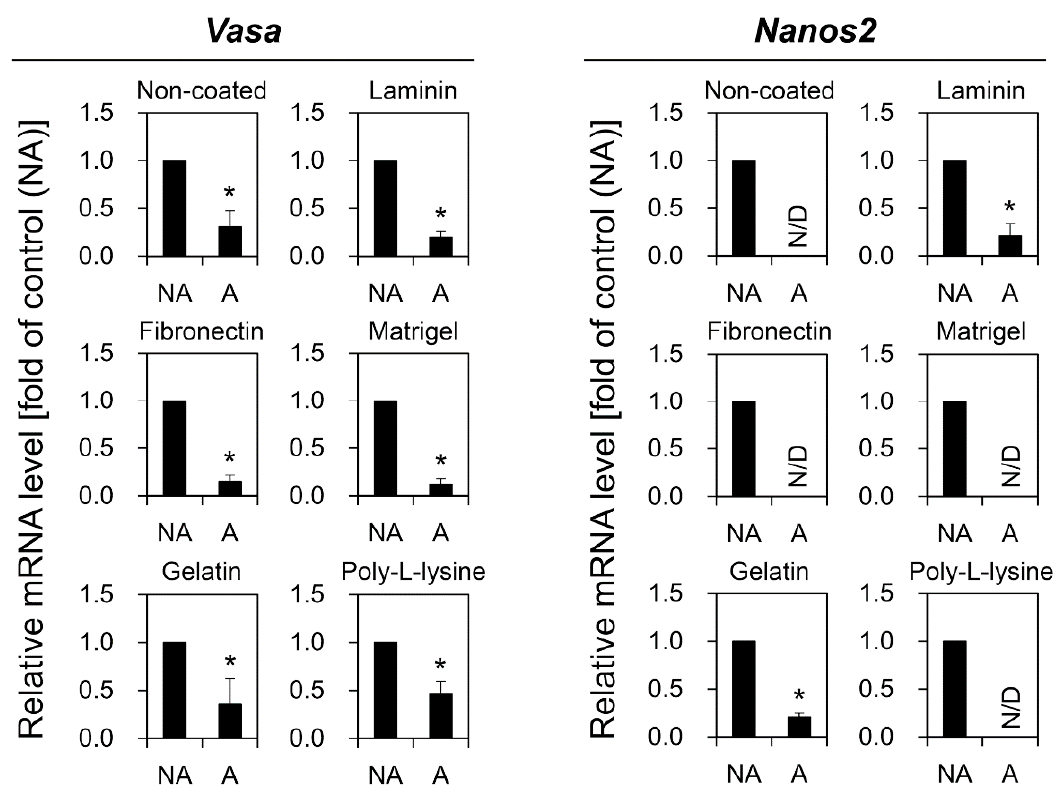
Figure 3. Comparison of Vasa and Nanos2 expression between non-adhesive (NA) and adhesive (A) cells after differential plating (DP). Crude TO from five adult females was subjected to DP on plates coated with different adhesion molecules including gelatin, fibronectin, laminin, Matrigel, and poly- L-lysine. NA and A cells were collected separately and analyzed by qRT-PCR to compare Vasa and Nanos2 expression levels. Regardless of the type of adhesion molecule used, the expression levels of both Vasa and Nanos2 were significantly higher in NA than A cells. The values are expressed as mean ± SD. Asterisks (*) indicate significant differences; p < 0.05. N/D, not detected.